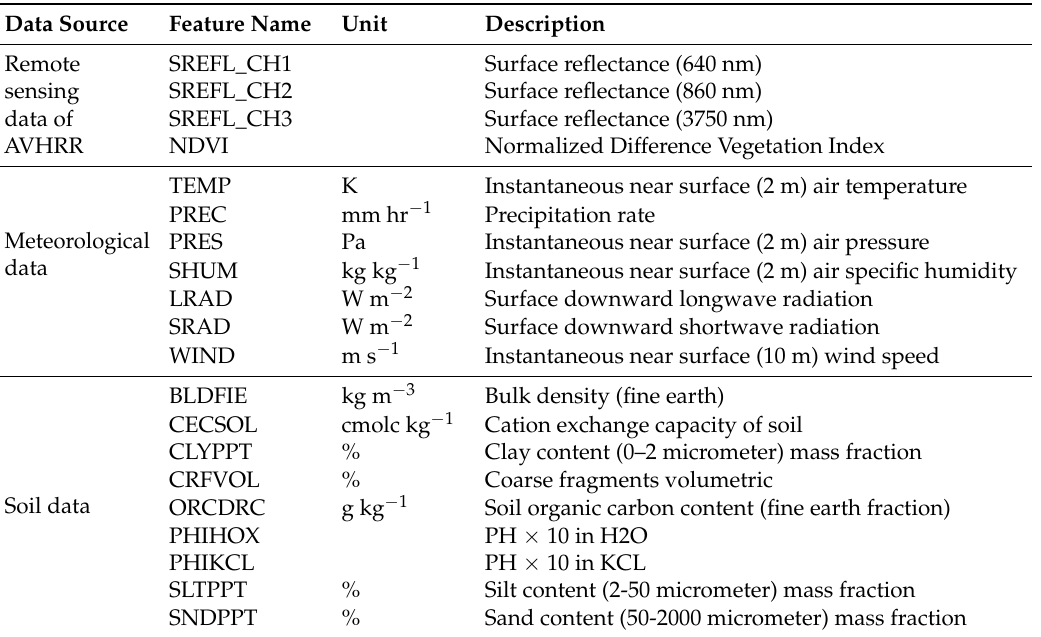
Table 1. Detailed information of the input